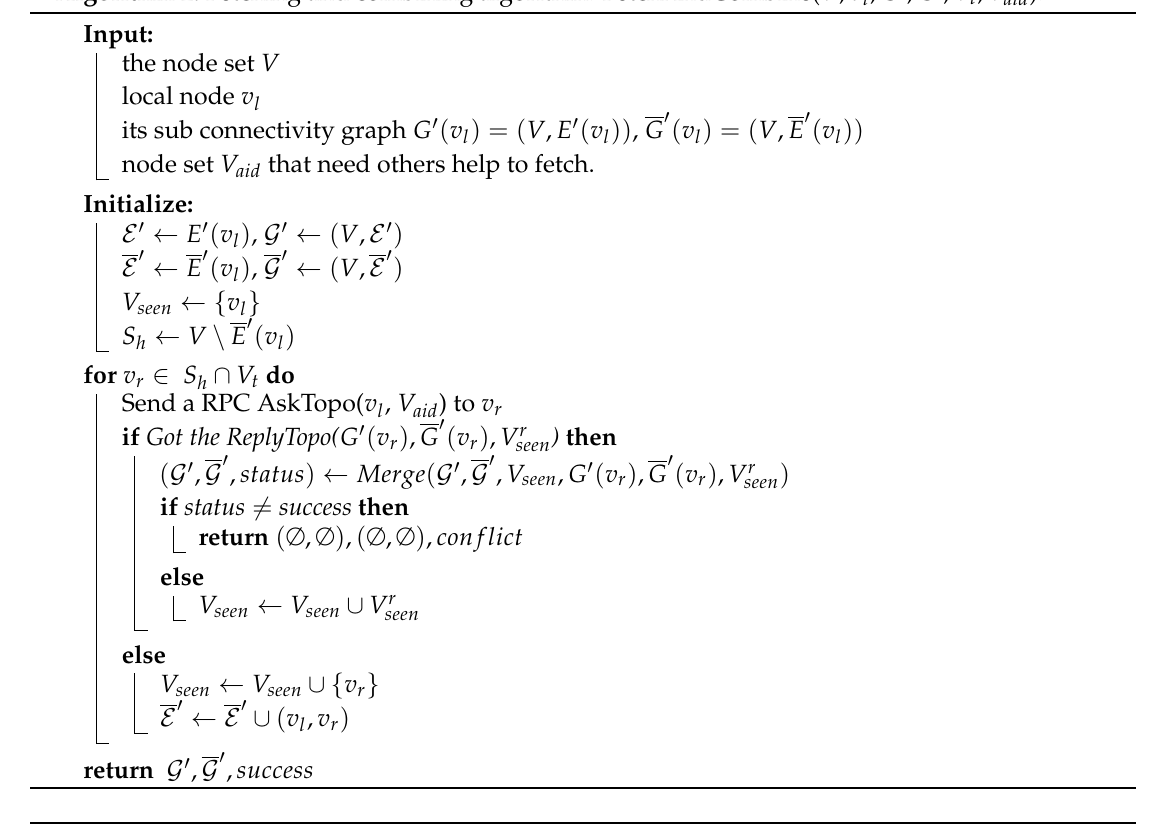
Algorithm 2: Fetching and combining algorithm. FetchAndCombine( V , v l , G (cid:48) , G